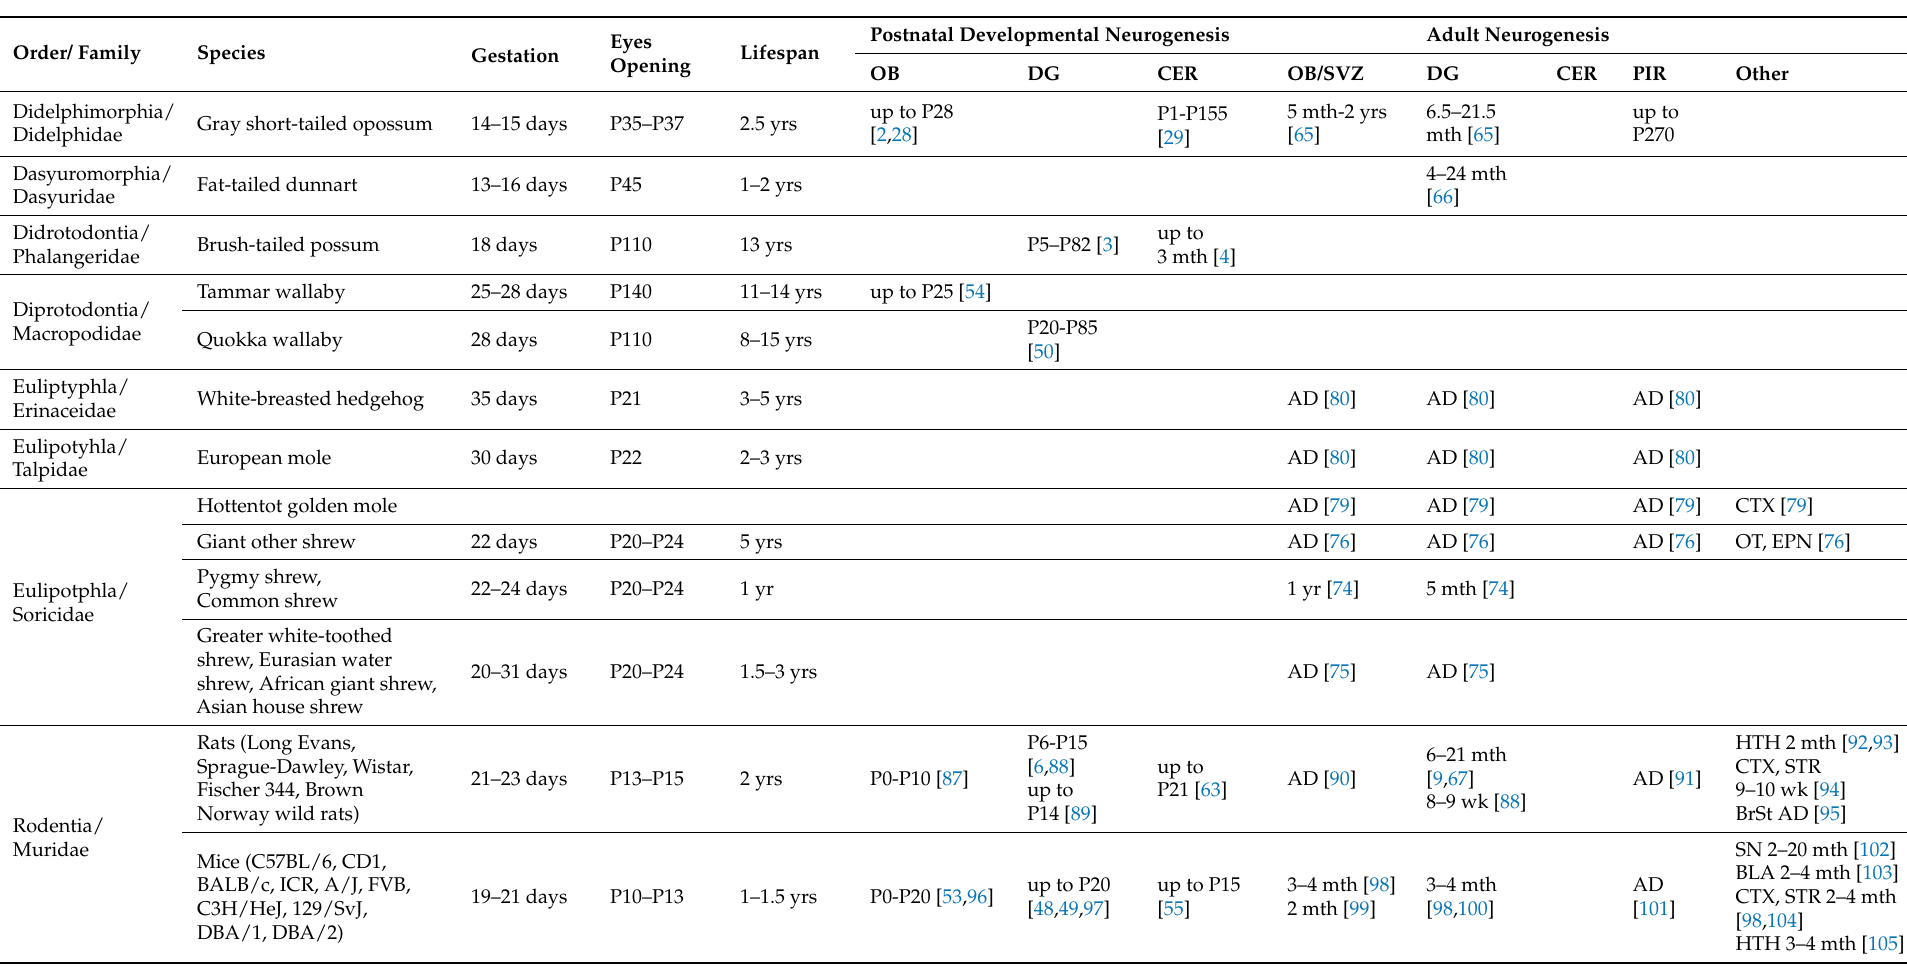
Table 1. Mammals that appear to have adult neurogenesis. AC: anterior commissure; AD: adult; AMG: amygdala; BLA: basolateral amygdala; BrST: brainstem; CER: cerebellum; CN: caudate nucleus; CP: caudate putamen; CTX: cerebral cortex; DG: dentate gyrus; EC: entorhinal cortex; EPN: endopiriform nucleus;